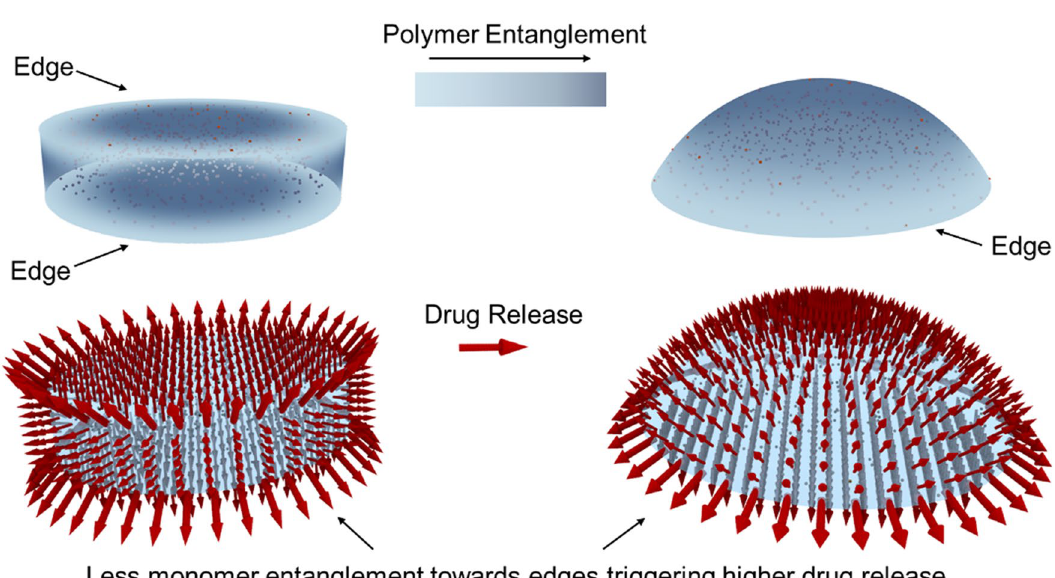
Figure 6. Schematic representation of the proposed mechanism of drug release from PVA-MNP cryogels. Top left: disc shaped gels with two edges, top right: spherical cap shaped gels with one edge. Polymer entanglement is less close to the edges of the gels as indicated by the lighter color and high towards the centers as indicated by the darker color. Bottom left and right: arrows depicting varying levels of drug release from disc and spherical cap gels. Larger arrows indicate higher drug release close to the edges and the smaller arrows indicate less release towards gel